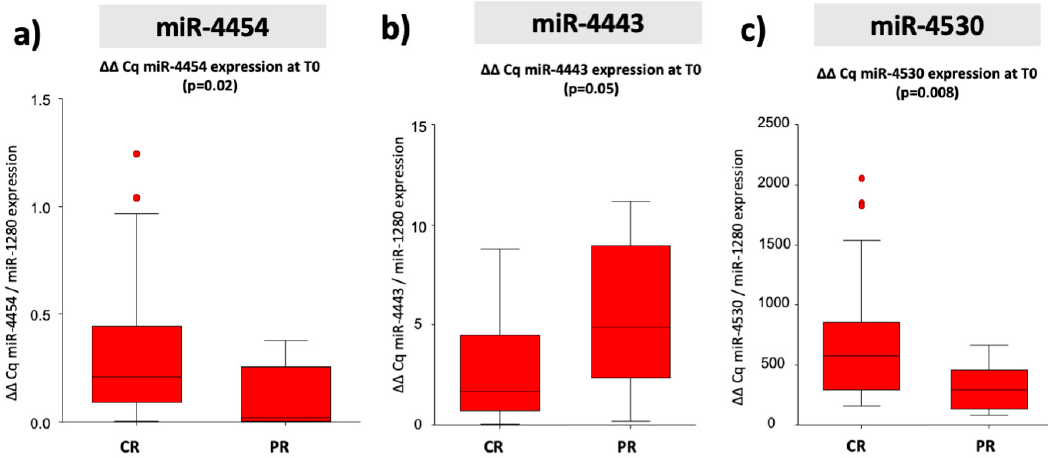
Figure 2. Mean ∆∆ Cq expression of miR-4443, miR-4454, and miR-4530 in patients underwent curative treatments. MiR-4443 ( a ) resulted in 1.95 fold of down-regulation in CR, while miR-4454 ( b ) and miR-4530 ( c ) showing a 2.83 and 2.33 fold of increase in CR. CR = complete responder, PRPD = partial responder and progressive diseases.